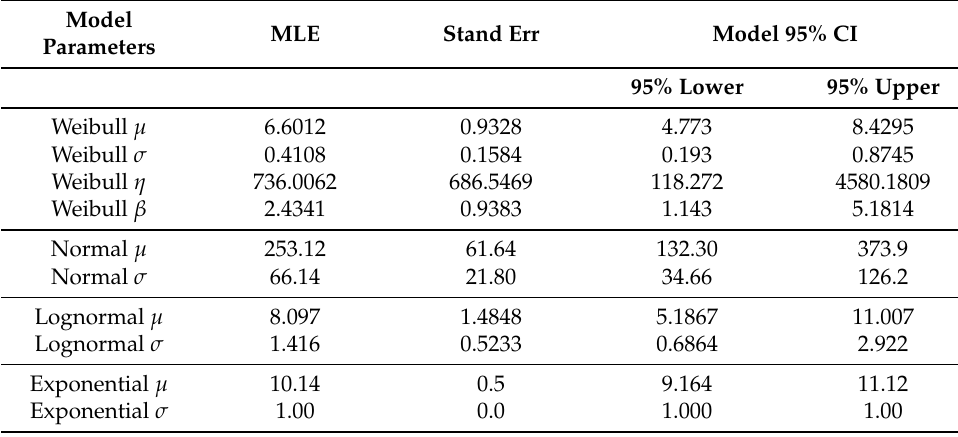
Table 3. Statistical model parameters optimized using